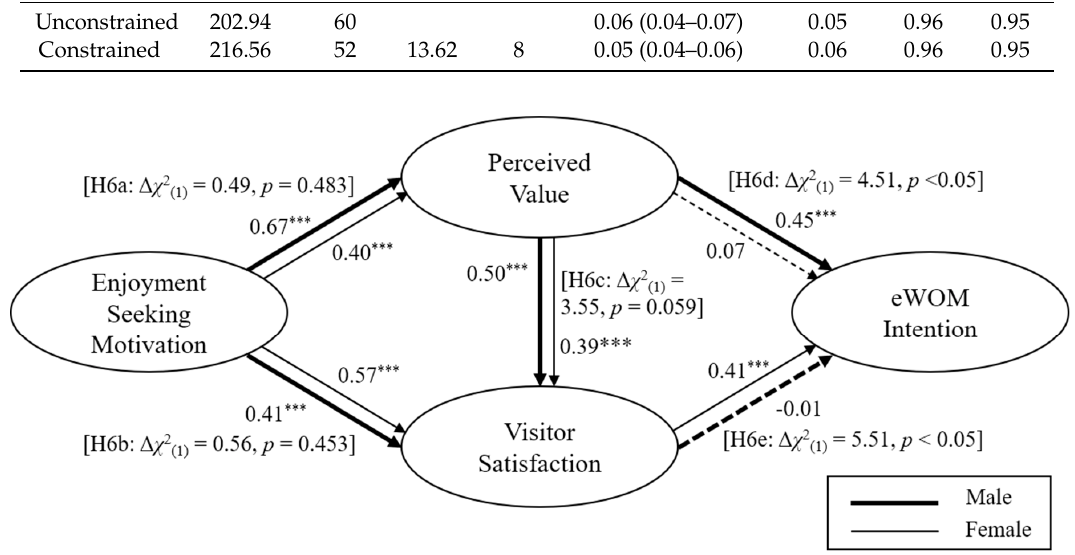
Figure 3. Results of the moderation effects of gender. χ 2 (98) = 104.343, p < 0.001, χ 2 / df = 2.113, CFI = 0.963, TLI = 0.950, RMSEA = 0.055 (90% CI: 0.045–0.065), SRMR = 0.053. *** p <